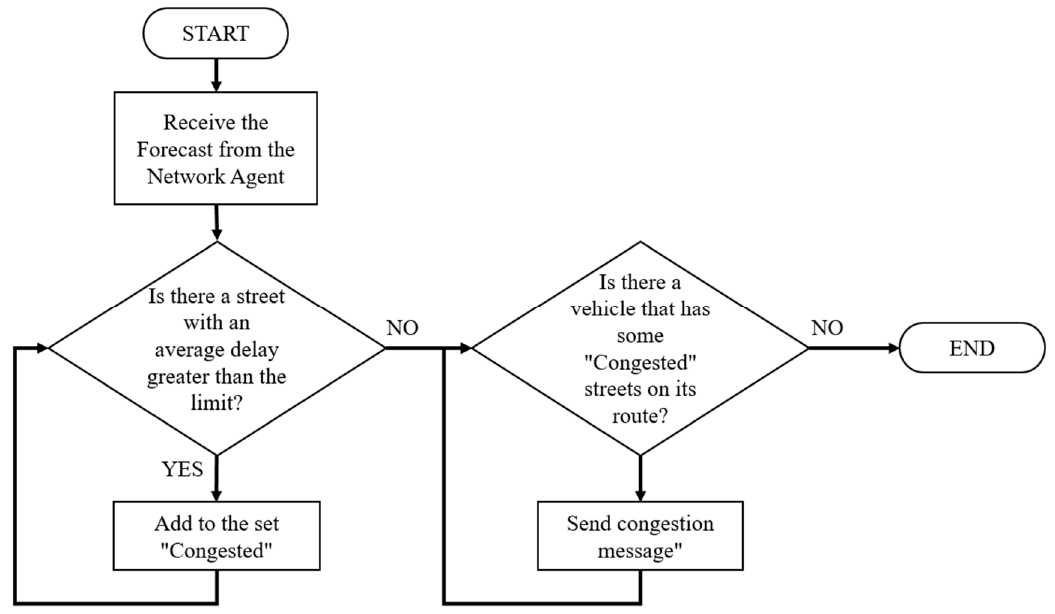
Figure 4. Flowchart illustrating the selection of congested streets and sending notices from the Zone Agent.